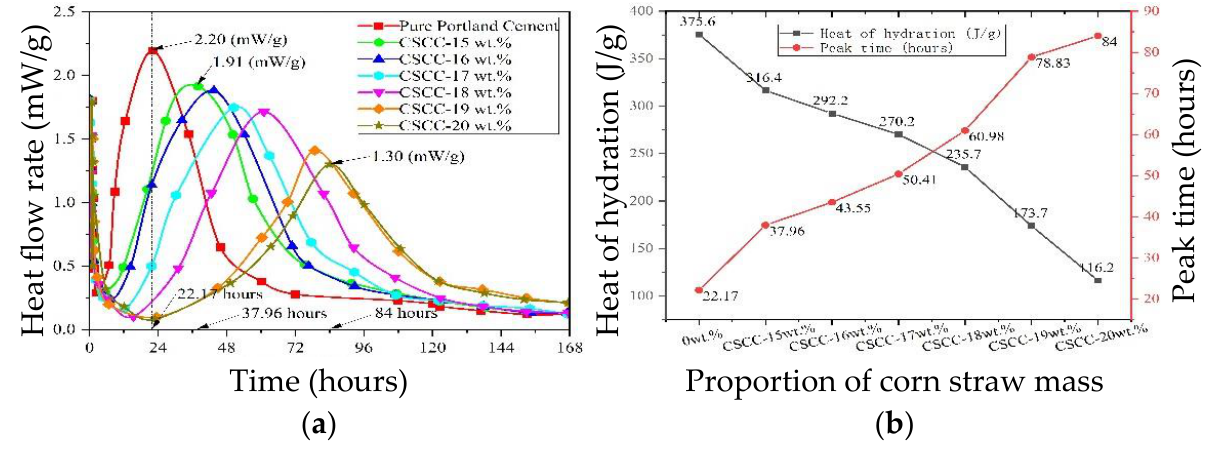
Figure 11. ( a ) Heat flow rate, ( b ) heat and hours of the different samples. Table 7. Heat flow rate and heat of hydration of CSCC under different quantities. Heat Flow Rate Heat of Hydration (J/g) Time